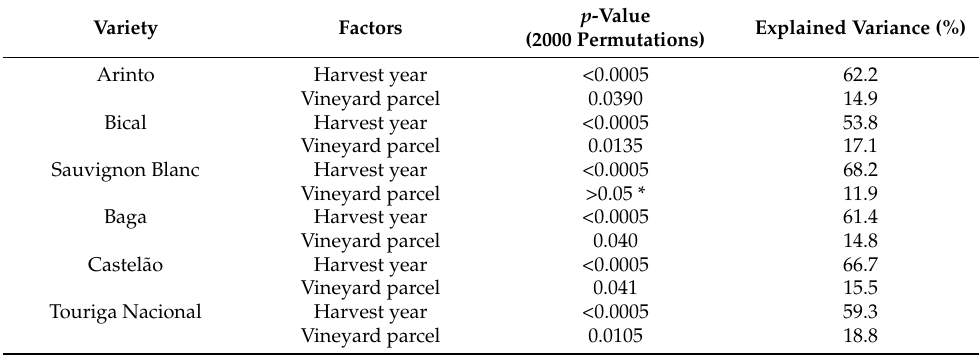
Table 4. Significance testing of factors harvest and parcel, for V. vinifera cv. Arinto, Bical, Sauvignon Blanc, Baga, Castel ã o, and Touriga Nacional varieties, determined at technological maturity. p -Value Variety Factors Explained Variance (2000 Permutations)